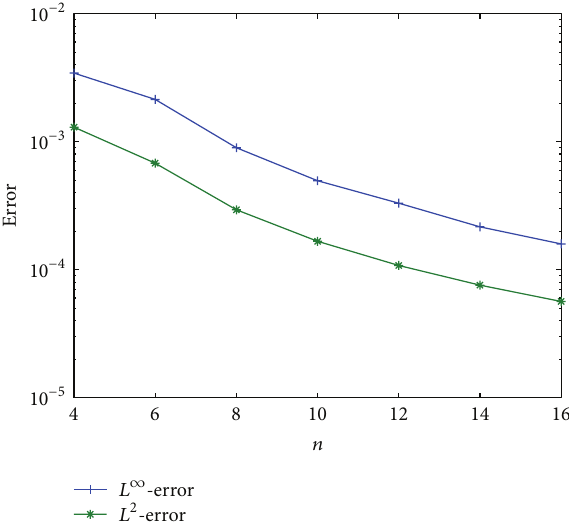
Figure 5: 𝐿 2 - and 𝐿 ∞ -errors versus 𝑛